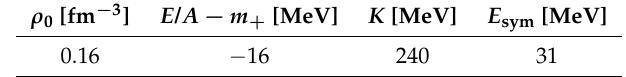
Table 1. Properties of the nuclear ground state at µ B = 923 MeV and the symmetry energy used in this work.